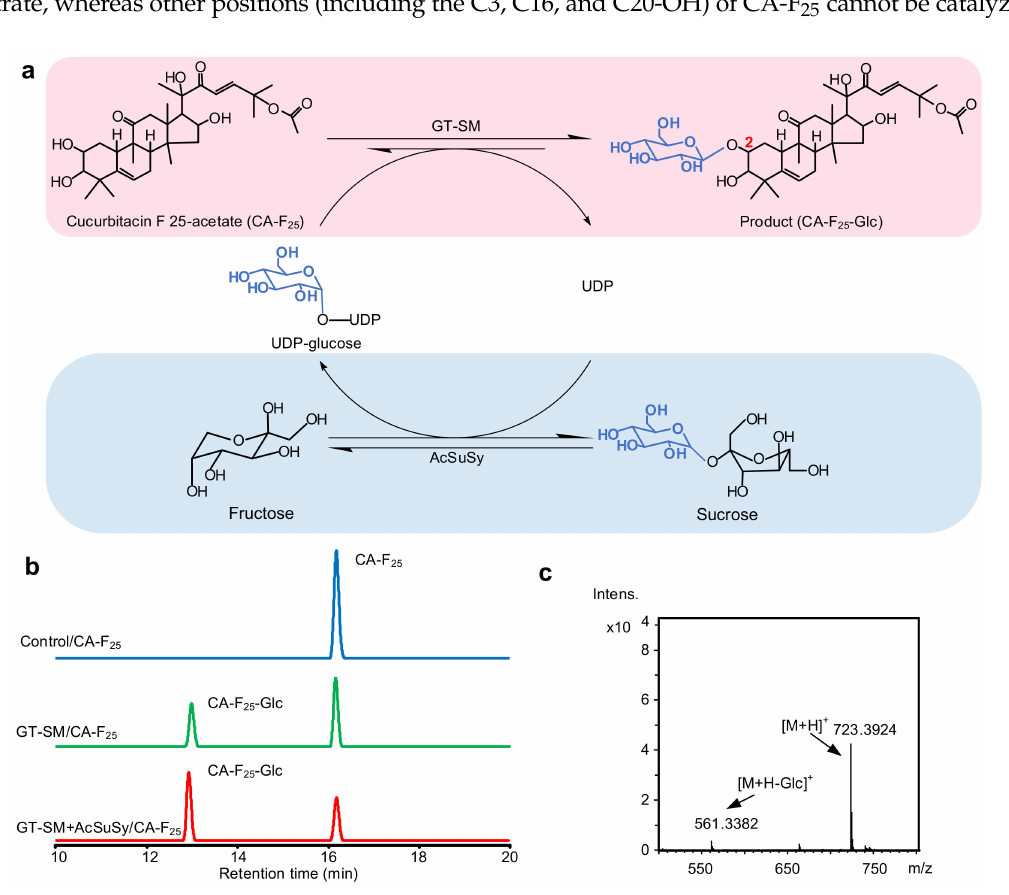
Figure 3. Function analysis of GT-SM in the glycosylation of cucurbitacin F 25-acetate (CA-F 25 ). ( a ) Scheme of GT-SM-AcSusy cascade reaction for the synthesis of CA-F 25 2-O-glucoside. ( b ) high-performance liquid chromatography (HPLC) chromatograms of glycosylated products of CA-F 25 without adding GT-SM (blue line), enzymatic reaction catalyzed by GT-SM using UDPG as sugar donor (green line) and one-pot reaction adding GT-SM and AcSusy (red line). ( c ) MS spectra for the